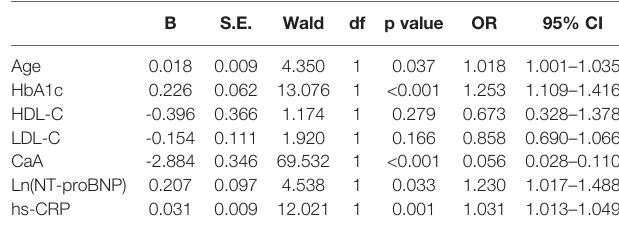
TABLE 2 | Echocardiographic examinations of subjects categorized by SDNN. Echocardiographic examinations